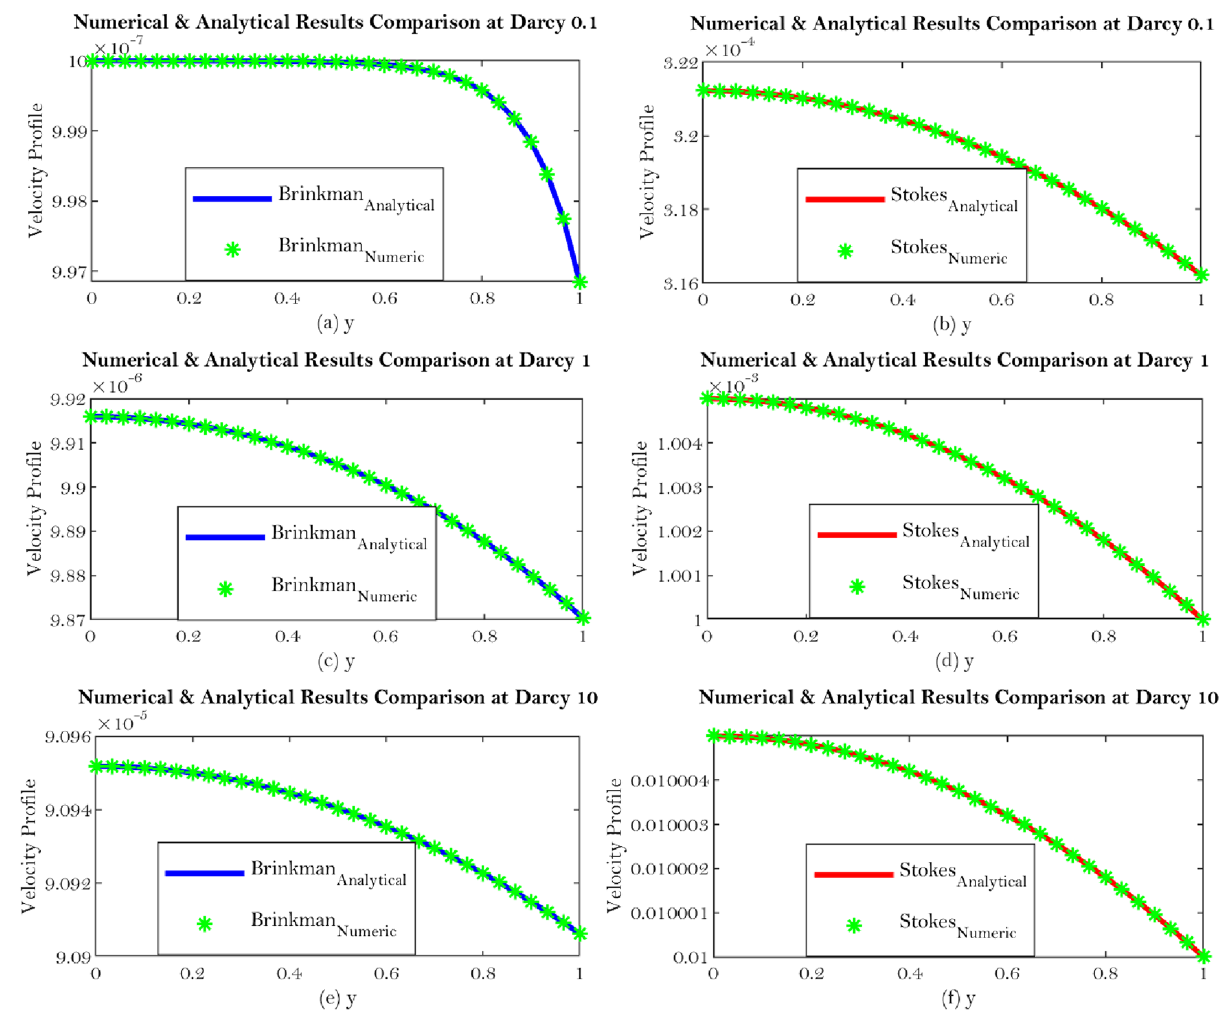
Figure 3. Shows the general solution comparison corresponding to the interface boundary condition which can be seen from Eqs. (14, For left boundary node, we use C